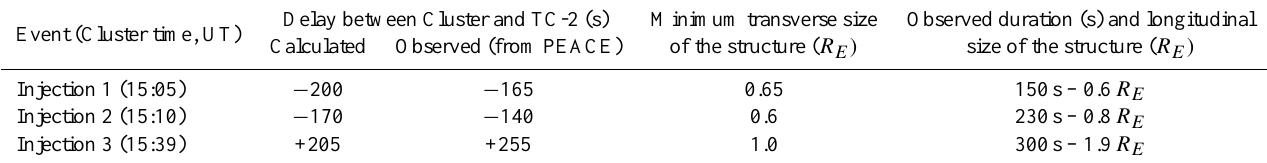
Table 2. Delay from Cluster to TC-2 and size of plasma injections at Cluster.